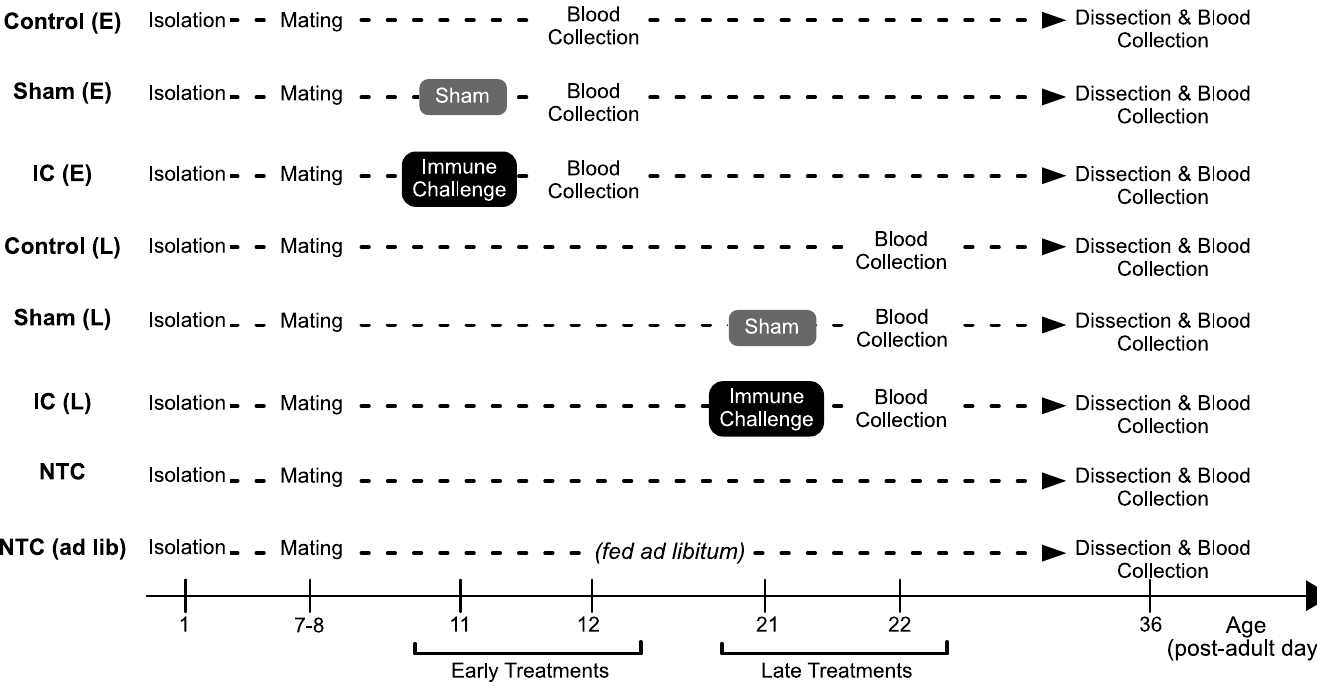
Fig 1. Experimental schedules. Each cricket used in this study (except for ones for the ovarian gene expression experiment) went through one of the eight experimental timelines. The horizontal axis shows the experimental timeline (day). IC: Immune Challenge, Sham: Sham injection, NTC: No-Treatment Control.